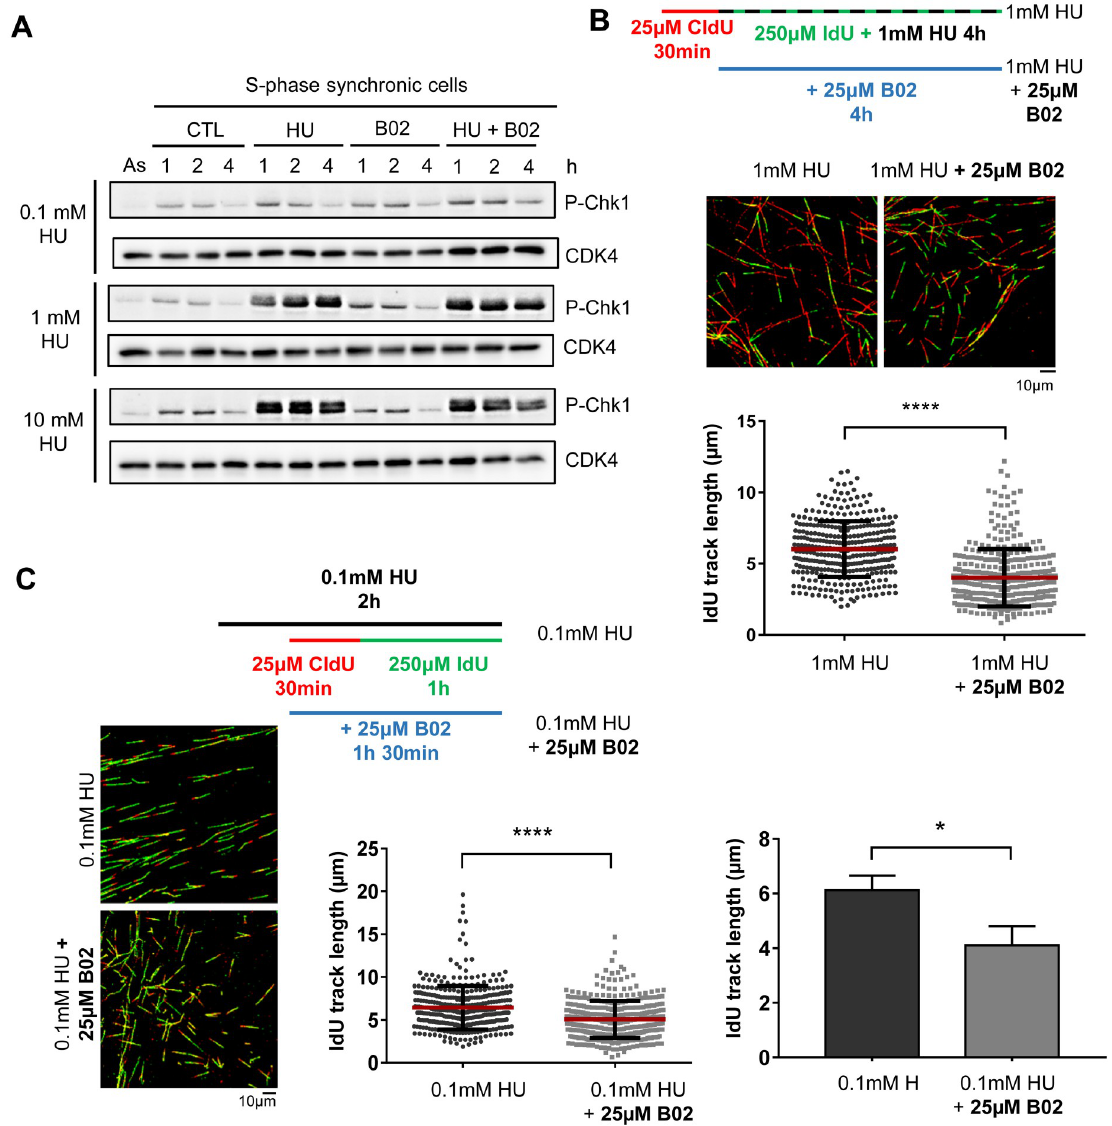
Fig 5. RAD51 inhibition affects fork progression under mild or bearable replication stress in hTERT-RPE cells. ( A ) Cells were synchronized in S phase by a thymidine block and 2h release. After that, they were treated with HU, B02 or left untreated (CTL) for the period indicated in the Fig. As.:asynchronic cells. Cells were lysed and P-Chk1 (Ser296) and CDK4 (loading control) were analyzed by western blot. ( B ) Cells were labelled as indicated (upper panel), adding the B02 inhibitor during the second analogue and HU treatment. After labelling, cells were harvested and prepared for DNA fiber analysis. Representative images are shown. At least 300 fibers of each condition in each experiment were measured. Quantification of a representative experiment out of two is shown (bottom-right panel, Mann-Whitney test, ���� P value < 0.0001). ( C ) Cells were labelled as indicated (upper panel). HU was added 30 minutes before DNA labelling (this dose of HU is not completely inhibiting replication). B02 was added where it is indicated. After labelling, cells were harvested and prepared for DNA fiber analysis. Representative images are shown (left panels). At least 250 fibers of each condition in each experiment were measured. One representative experiment out of four is shown in middle graph (Mann-Whitney test, ���� P value < 0.0001; each dot represents a fiber track length). Means and standard deviation (bars) of four experiments are shown right graph (paired t-test, � P value < 0.05). See data used for quantification in S1